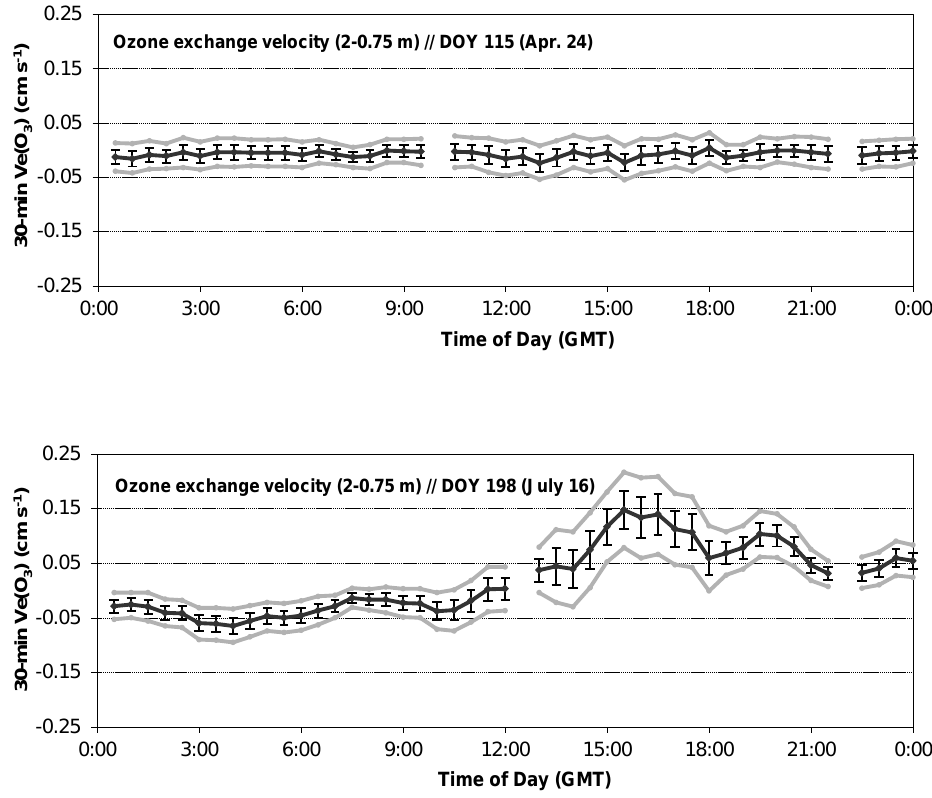
Fig. 7. Results for the ozone deposition velocity determination for layer { 2–0.75m } for two examples from a day during the spring (DOY 115 [24 April]) and the summer (DOY 198 [16 July]) 2004 periods. Error bars represent the 1- σ uncertainty from 5000 Monte Carlo simulations, while grey lines represent the lower and upper 95% confidence levels (2 σ ) for each 30-min gradient flux calculation. Gaps in the time series are due to the inter-comparison periods. Summit local time is 2h earlier than GMT.